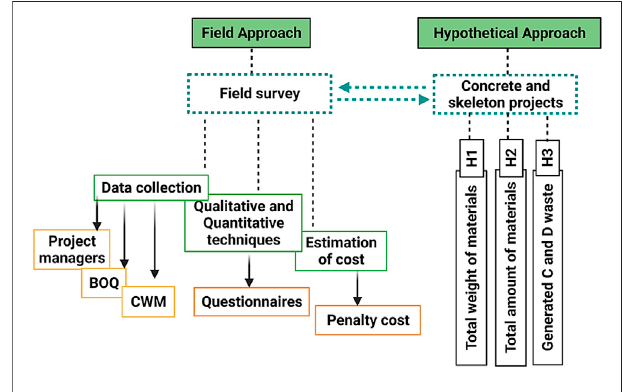
FIGURE 3 | Hypothetical and fi eld